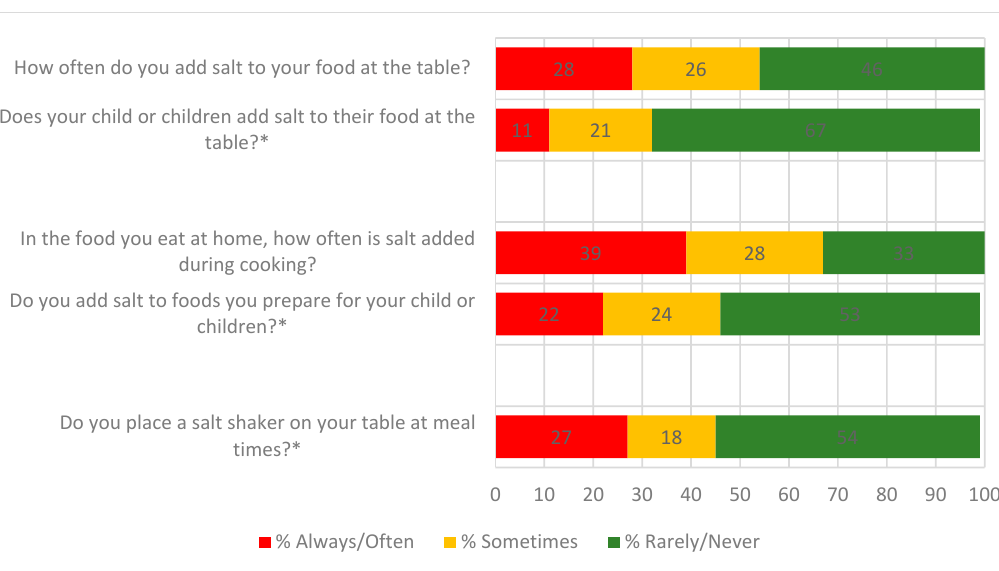
Figure 2. Discretionary salt use behaviours of parents and those related to their child/children. * Parent reported behaviour for child/children in the parent-specific component of the questionnaire.